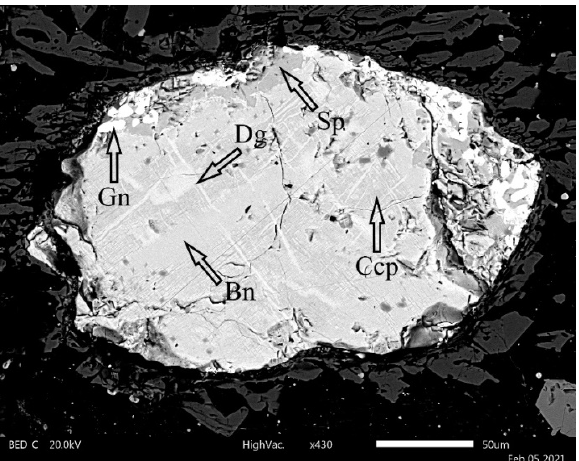
Figure 4. Backscattered electron image of sample CSA (abbreviations: Hd—hedenbergite; Mag—magnetite; Sul—sulphide droplets; Gl—galena).